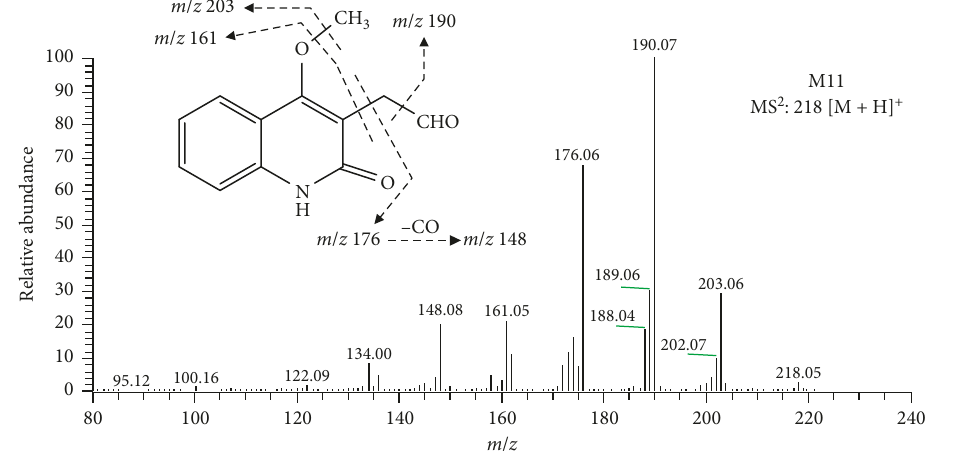
Figure 4: The proposed fragmental pathway and the MS 2 bar graph of